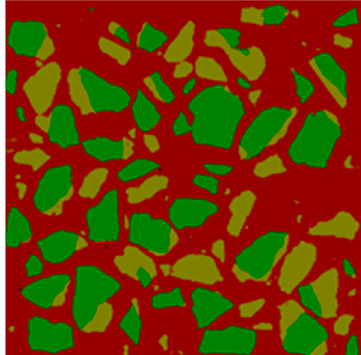
Figure 5. Image method for measuring the content of old mortar.